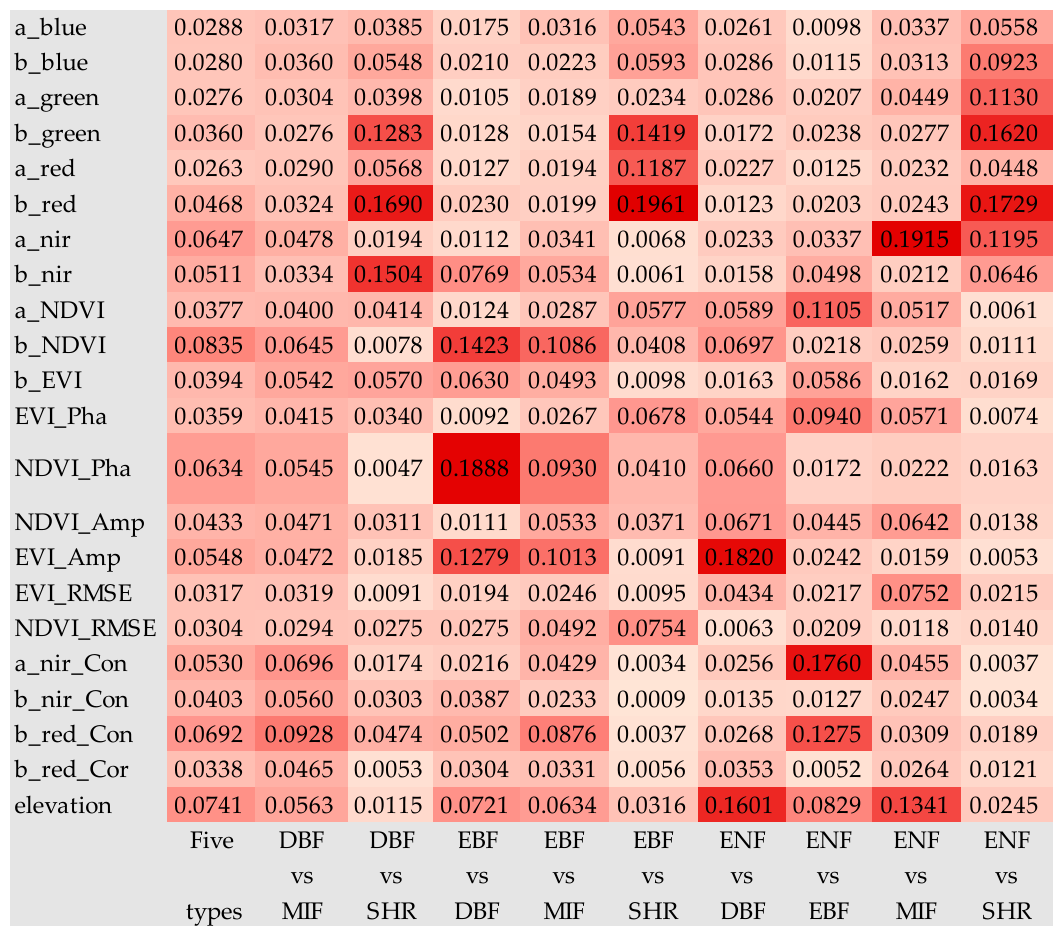
Figure 7. Feature importance score. Feature importance for discriminating various combinations of forest types, where a and b represent the composited image of April to September and September to April, respectively; for example, a_blue corresponds the blue band from the composited image of April to September.